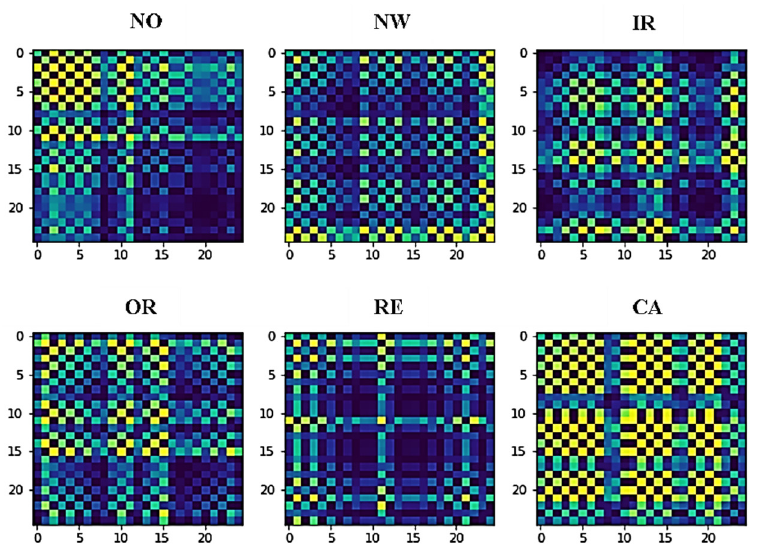
Figure 8. Examples of the generated vibration image using the GAF technique for bearing vibration with six health conditions.